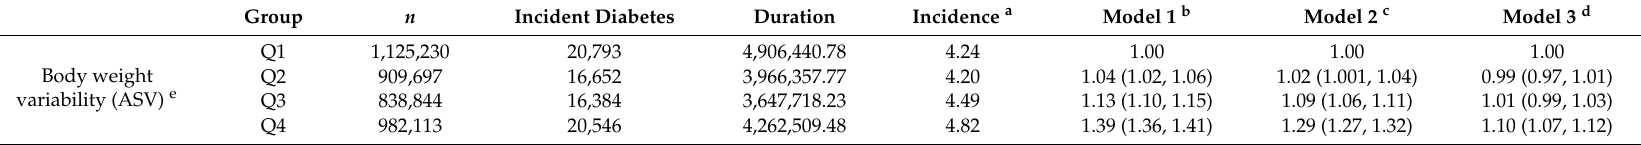
Table 2. Risk of new-onset diabetes according to body weight